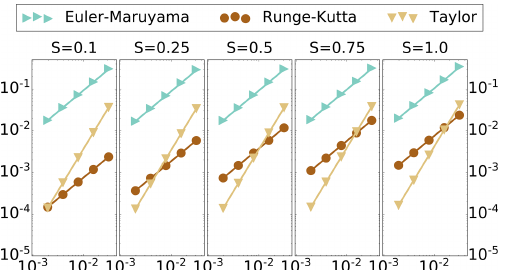
Figure 2. Weak convergence benchmark. Vertical axis – discretiza- tion error, log scale. Horizontal axis – step size, log scale. Diffusion level s . Length of time T = 0 .